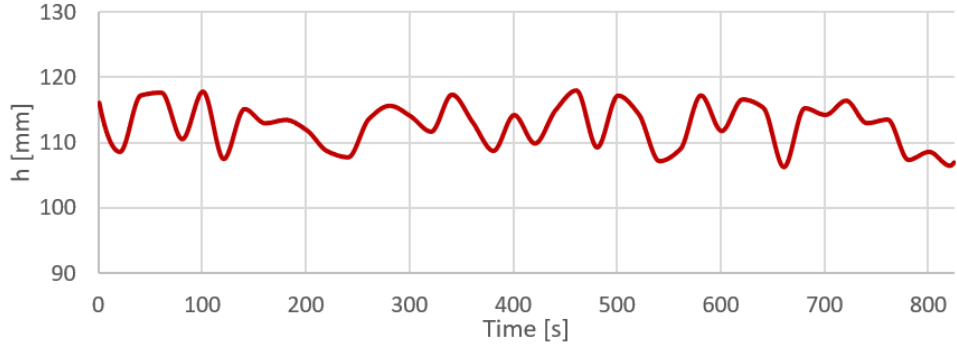
Figure 8. Waveform of changes in the position of the distribution layer in compartment 1 when using the fuzzy controller.